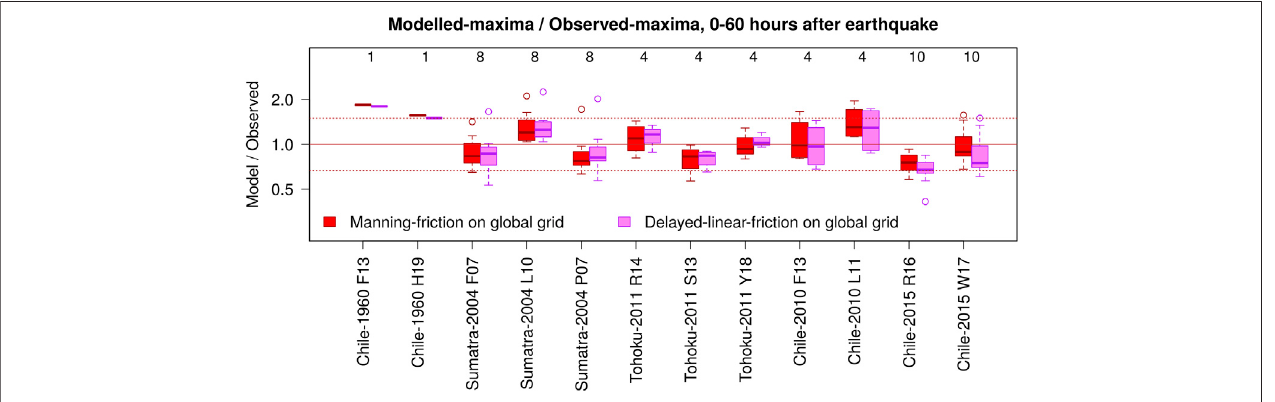
FIGURE 12 | Per-inversions boxplots of ratio between modeled and observed tsunami maxima at all gauges, for simulations of 60 h, and two model types. The integers above the boxes count the tide-gauge observations. Dotted horizontal lines are y (cid:2) 1 . 5 and y (cid:2) 1 / 1 . 5. De fi nition of the boxplots: The box de fi nes the inter- quartilerangewiththecentral linede fi ningthemedian. The “ whiskers ” extendfrom theboxforatmost1.5inter-quartileranges, oruptotherangeofthedata.Pointsnot covered bywhiskersareplotteddirectly.TheChile 1960sources only have onegaugerecord thatcovers the 0 – 60 h simulation ( Figure 7 ),sothe boxplot reduces to a horizontal